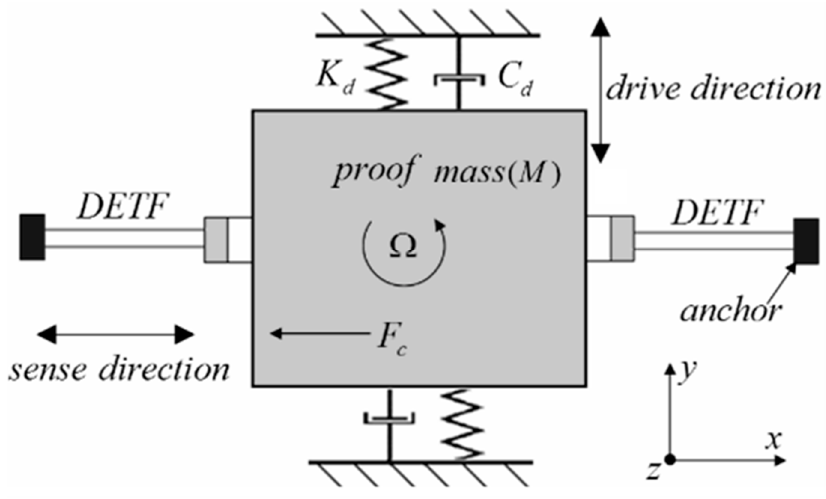
Figure 4. Schematic diagram of resonant gyroscope with direct frequency output.